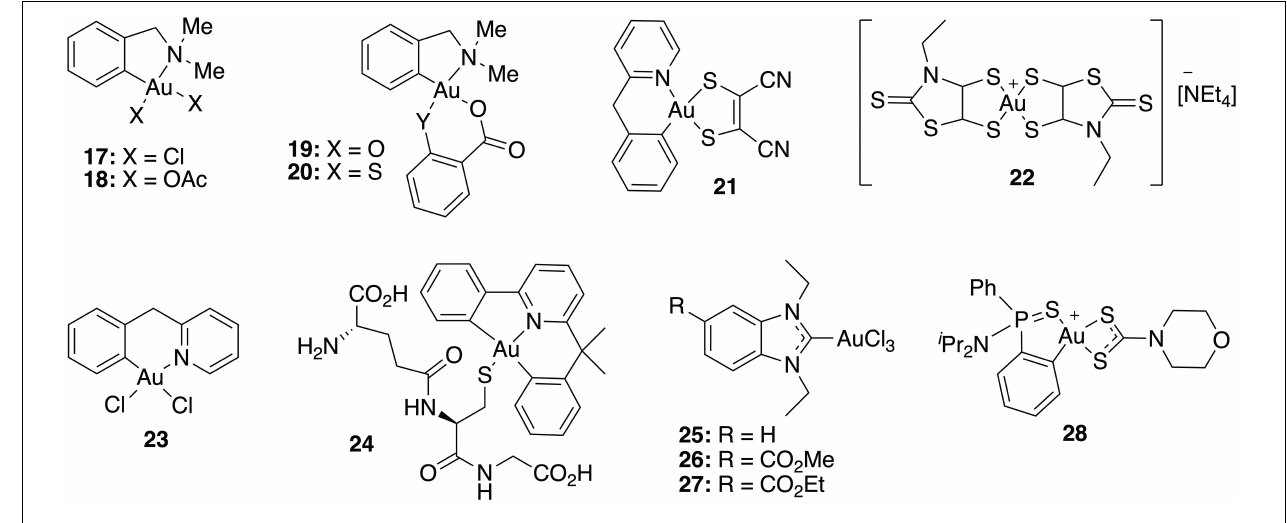
FIGURE 3 | Most representative gold(III) complexes with antimicrobial activity. TABLE 4 | Antibacterial activity (MIC) of the gold(III) complexes.